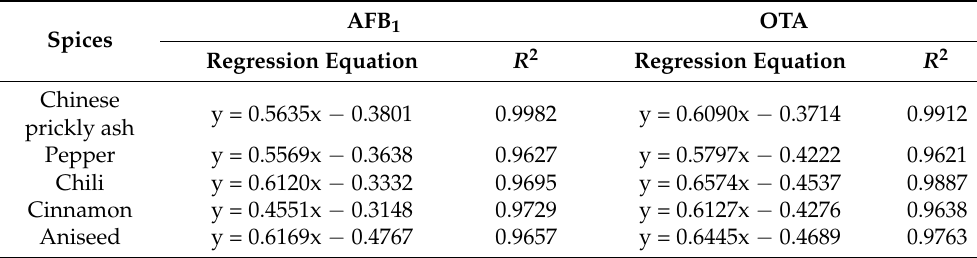
Table 4. Standard curve of different spice